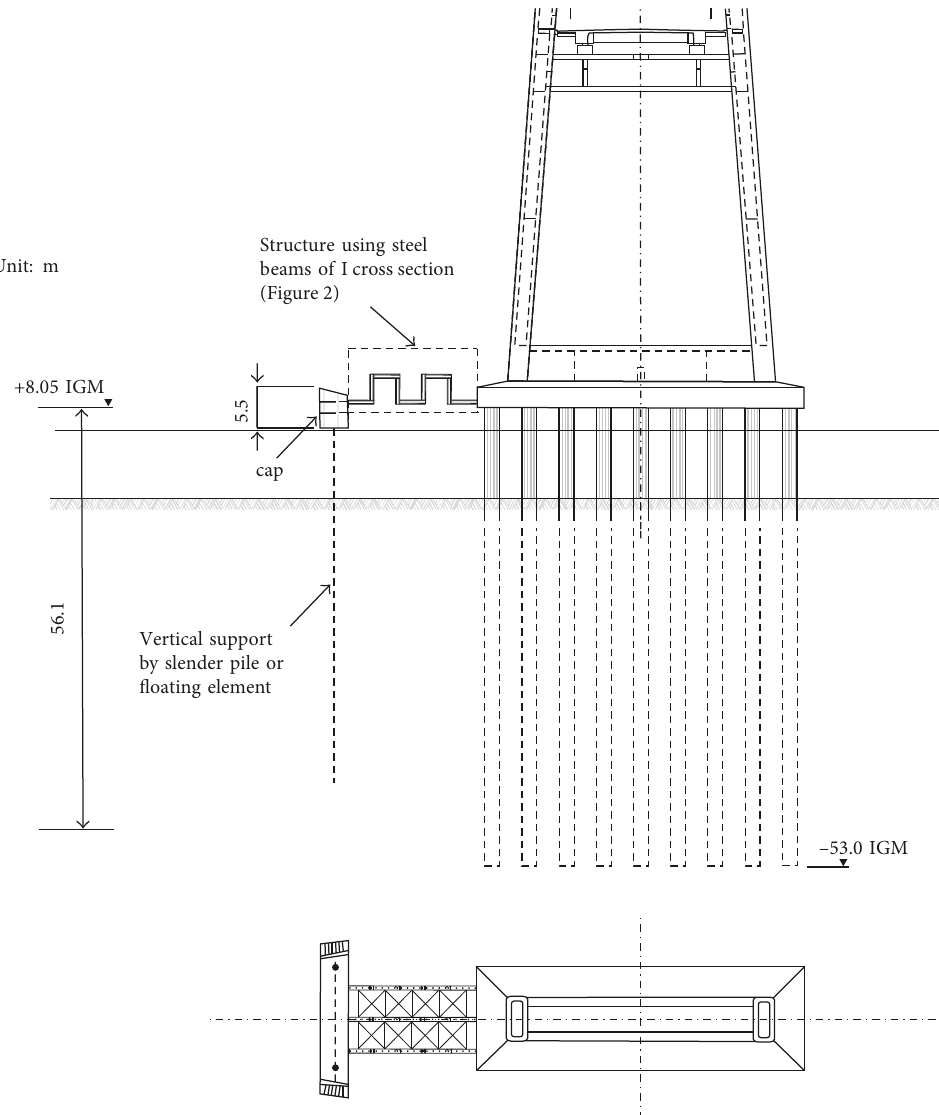
Figure 1: The structure connecting the cap and the bridge pier using steel beams of I cross section for a sample bridge pylon